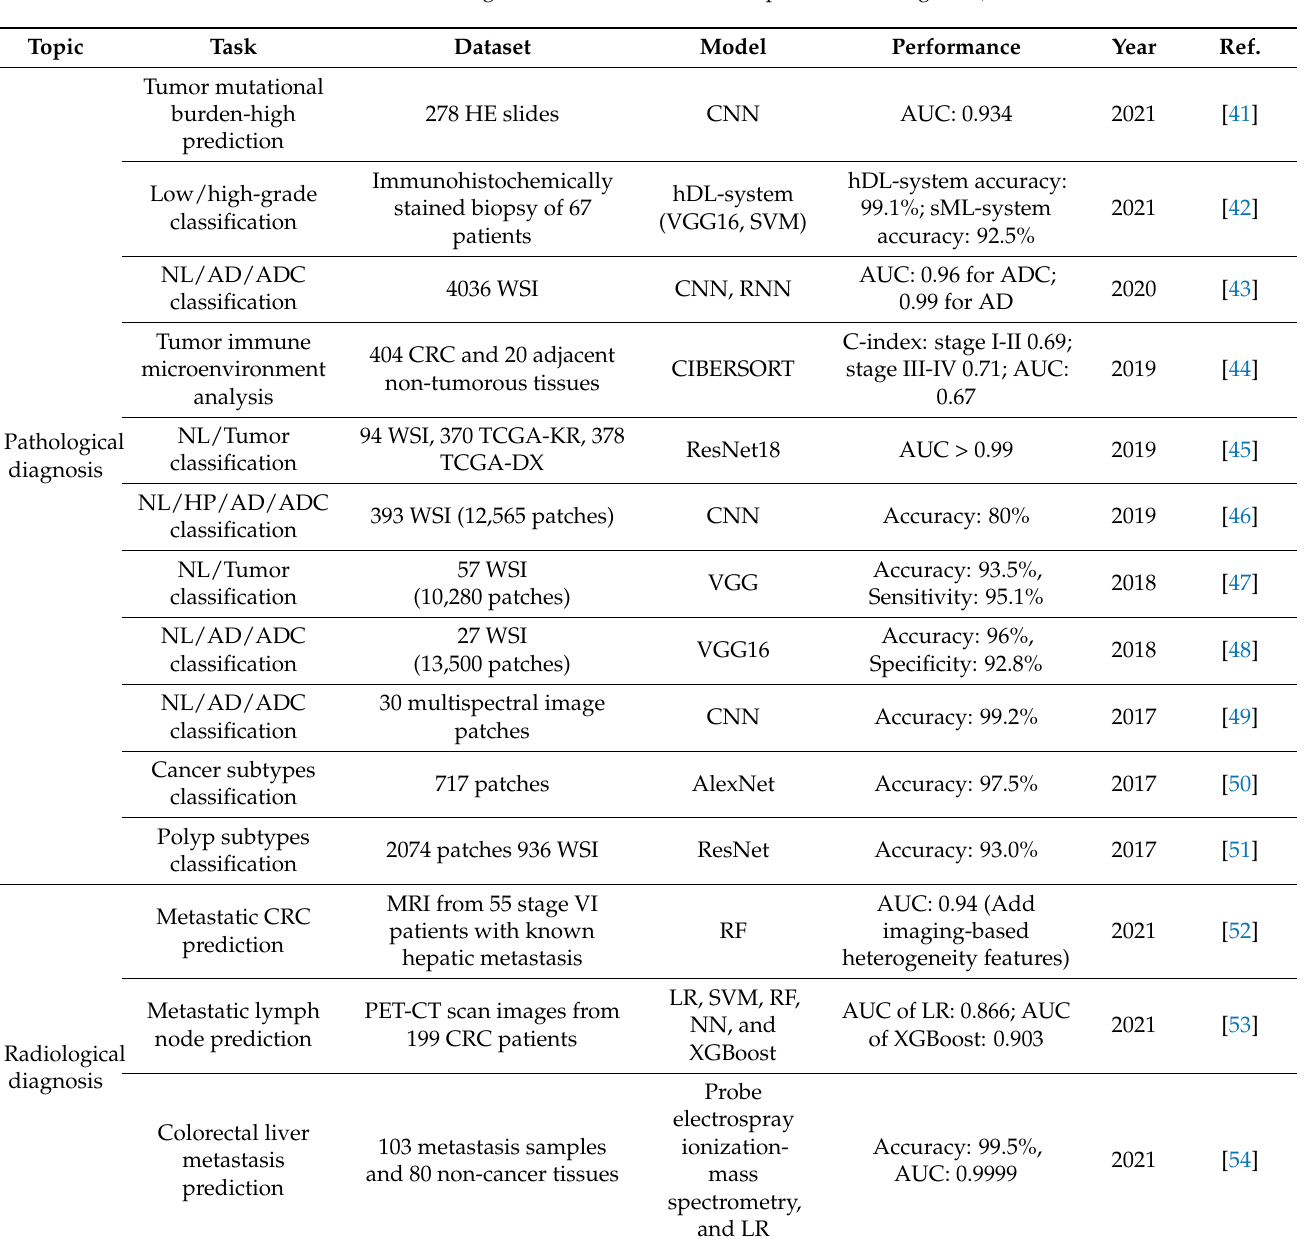
Table 2. Summary of AI models for CRC diagnosis and staging session. (CNN, convolutional neural network; AUC, area under the curve; SVM, support vector machine; PNN, probabilistic neural network; NL, normal mucosa; AD, adenoma; ADC, adenocarcinoma; WSI, whole slide images; RNN, recurrent neural network; TCGA, The Cancer Genome Atlas; ResNet, residual network architecture; HP, hyperplastic polyp; VGG, visual geometry group; RF, random forest; PET-CT, positron emission tomography or computed tomography; LR, logistic regression; NN, neural network; XGBoost, extreme gradient boosting; CT, computed tomography; MRI, magnetic resonance imaging; Faster R-CNN, faster region-based CNN; CAD, computer aided diagnosis). Dataset Model Performance Year